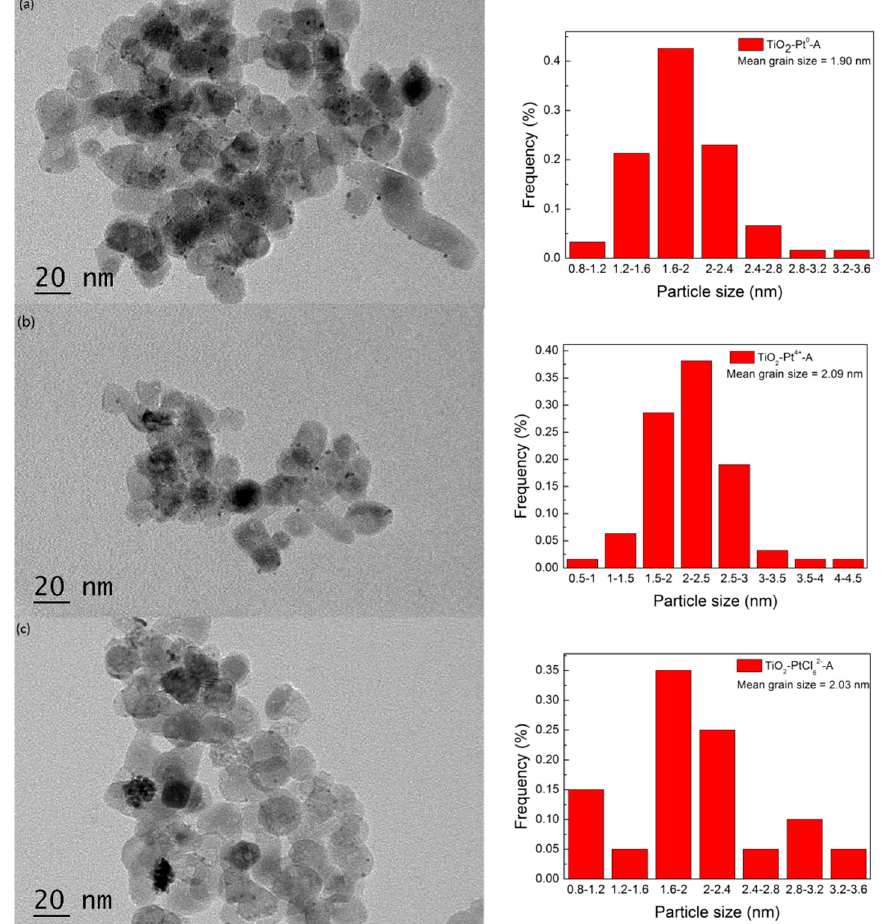
Figure 4. TEM images of the used Pt/TiO 2 samples via three different Pt sources and the size distributions of Pt particles ( a ) TiO 2 -Pt 0 , ( b ) TiO 2 -Pt 4+ and ( c ) TiO 2 -PtCl 62- .